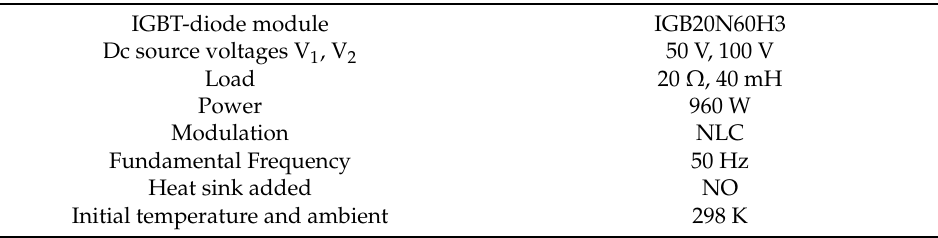
Table 6. Simulation and reliability model parameters.